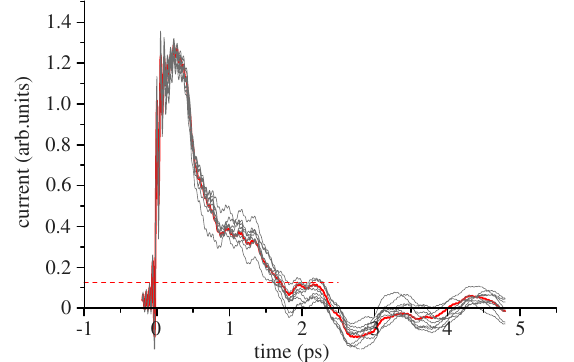
FIG. 8. The bunch profiles corresponding to the data of Fig. 7.